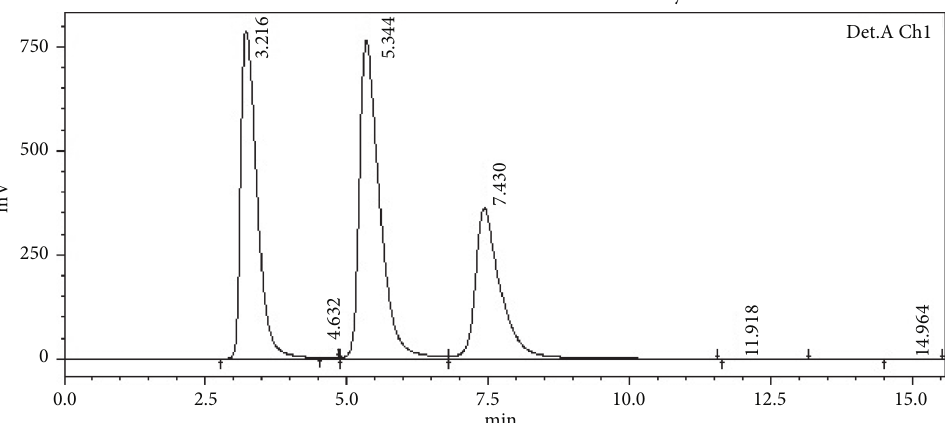
Figure 1: Chromatogram showing optimised separation of lamivudine (3.216min), nevirapine (5.344 min), and tenofovir disoproxil fumarate standard (7.430 min) (from left to right) using the developed method.